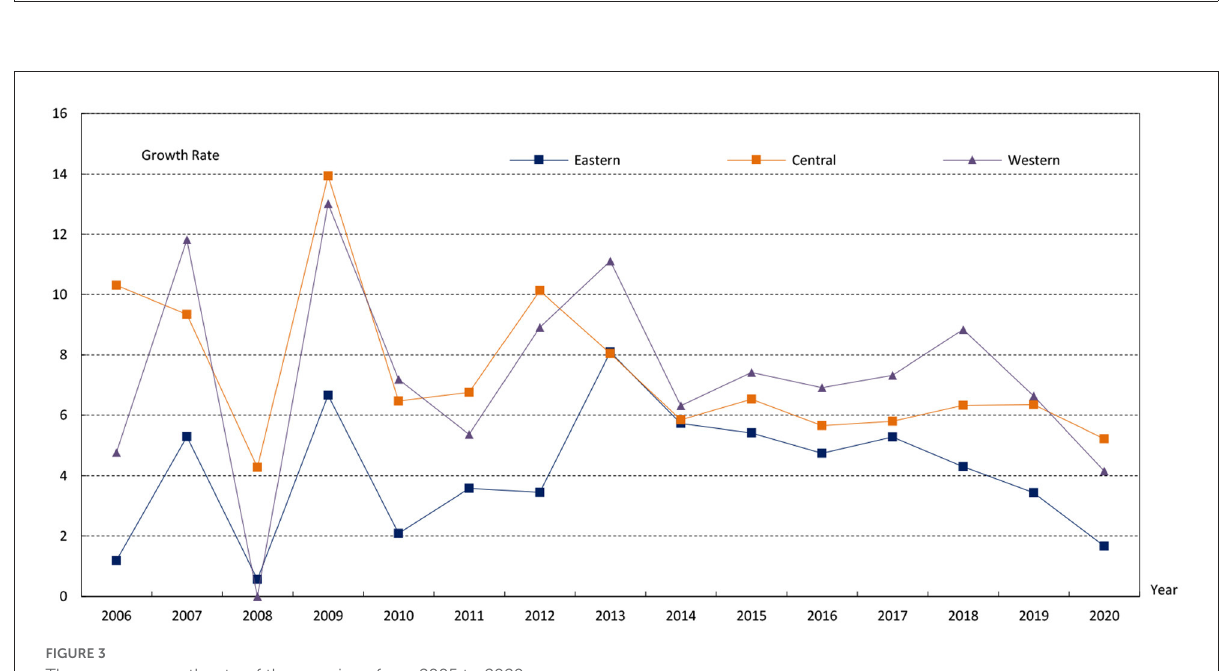
FIGURE3 The average growth rate of three regions from 2005 to